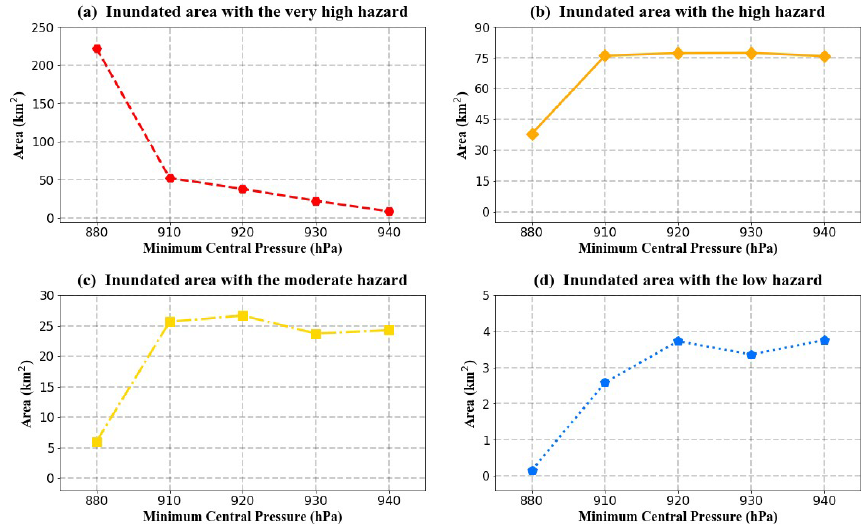
Figure 15. The simulated inundated areas with different hazard levels for each scenario.